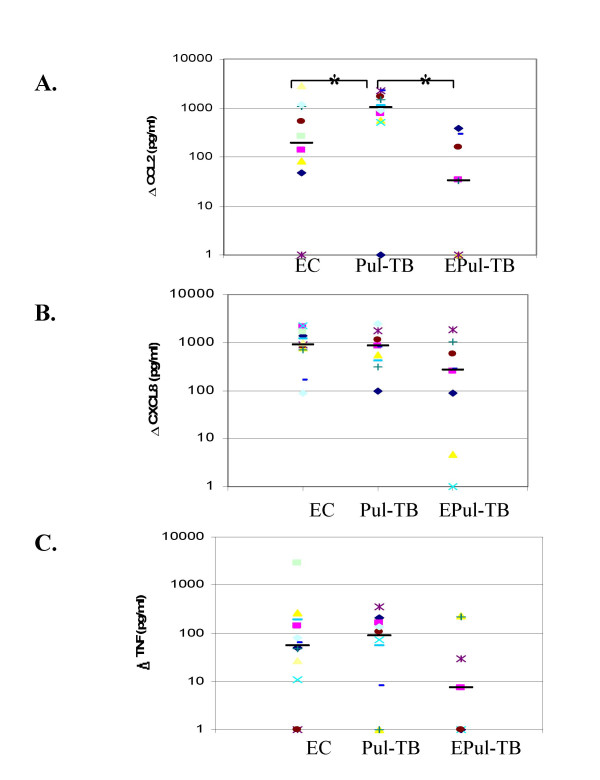
Increased BCG-induced CCL2 secretion in pulmonary tuberculosis. Whole blood cells were stimulated with M. bovis BCG as described in Fig. 2 and chemo/cytokine secretion measured at 18 h post-stimulation. Data for individual subjects; controls 'EC' (N = 12), pulmonary 'Pul-TB' (N = 10) and extra pulmonary 'EPul-TB' (N = 8) tuberculosis is illustrated. The median value is indicated by a horizontal line. Baseline levels of cytokines have been subtracted in each case 'Δ '. A. CCL2, B. CXCL8 and C. TNFα. Pair-wise differences were calculated using the Mann-Whitney U test with P < 0.05, '*'.